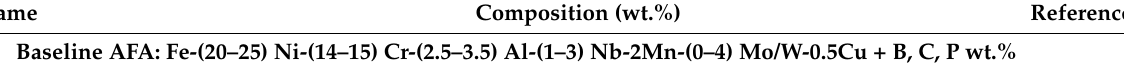
Table 1. Typical AFA alloys